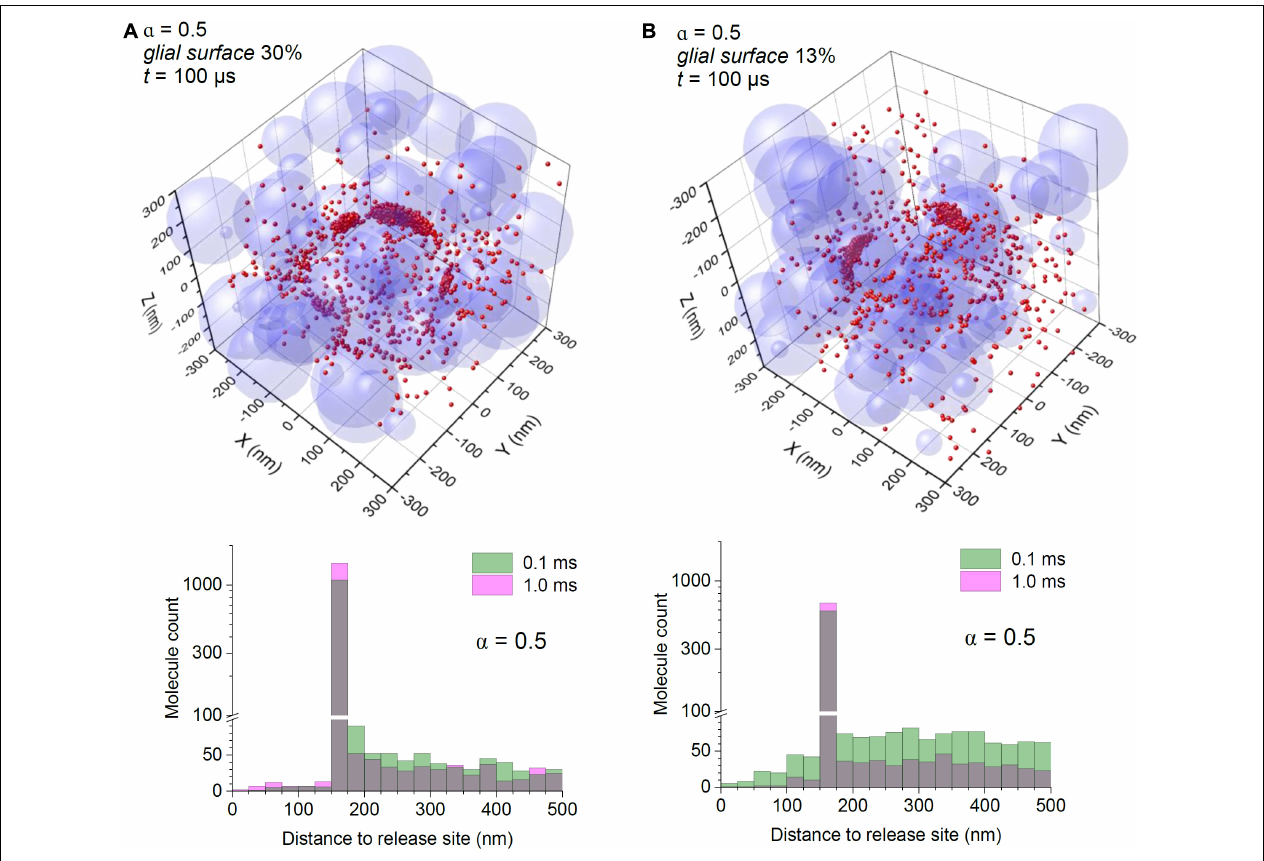
FIGURE 3 | Astroglial high-affinity transporters control the scatter of escaping glutamate molecules under conditions of expanded extracellular space. (A) Simulations as in Figure 2 , with the particle-surface binding enabled, for each particle with probability of 0.3 (to mimic 30% chance of encountering cell membranes representing astroglia); tissue porosity α = 0.5; other notations as in Figure 2A . (B) Simulations as in (A) , but with the particle-surface binding enabled, for each particle with probability of 0.13 (to mimic 13% of neuropil cell membranes representing astroglia); other notations as in (A)